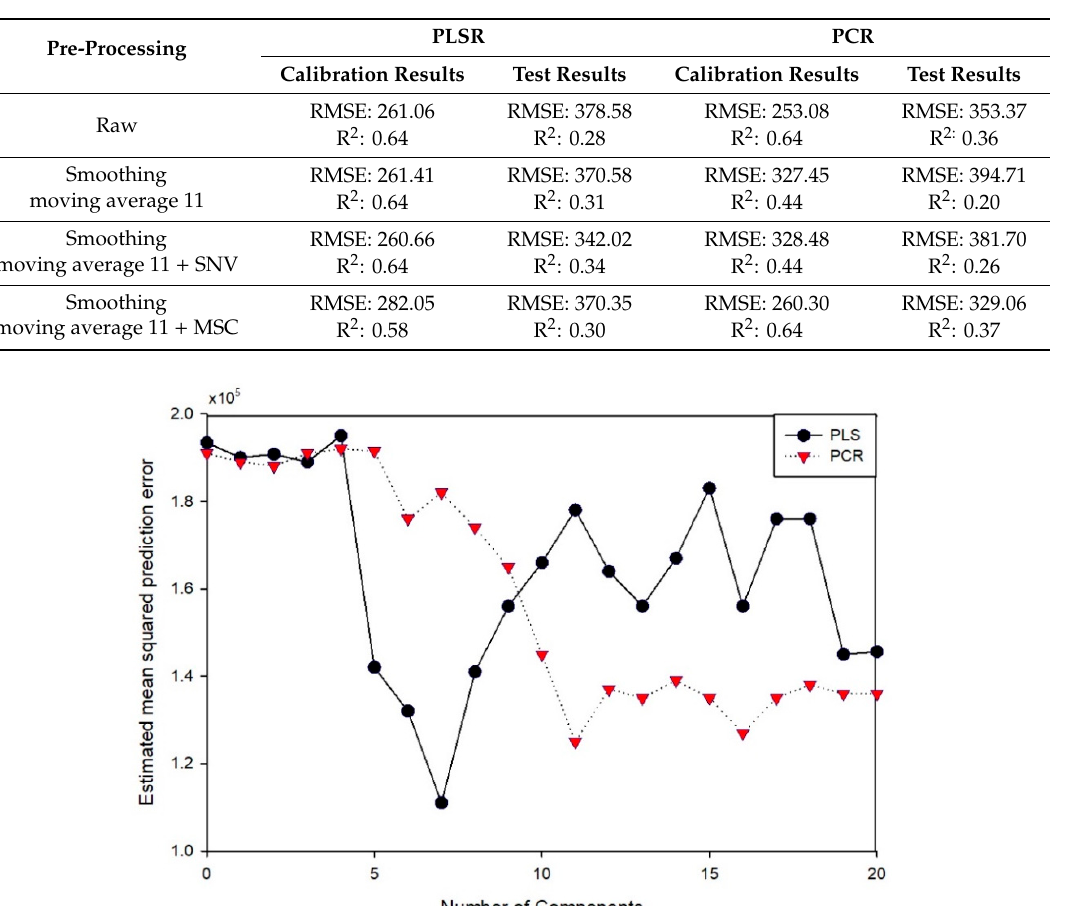
Figure 9. Comparison of partial least squares regression (PLSR) (Moving average 11and standard normal variate (SNV)) and principal components regression (PCR) (Moving average 11 and multiplicative scatter correction MSC) performance according to number of principal components.